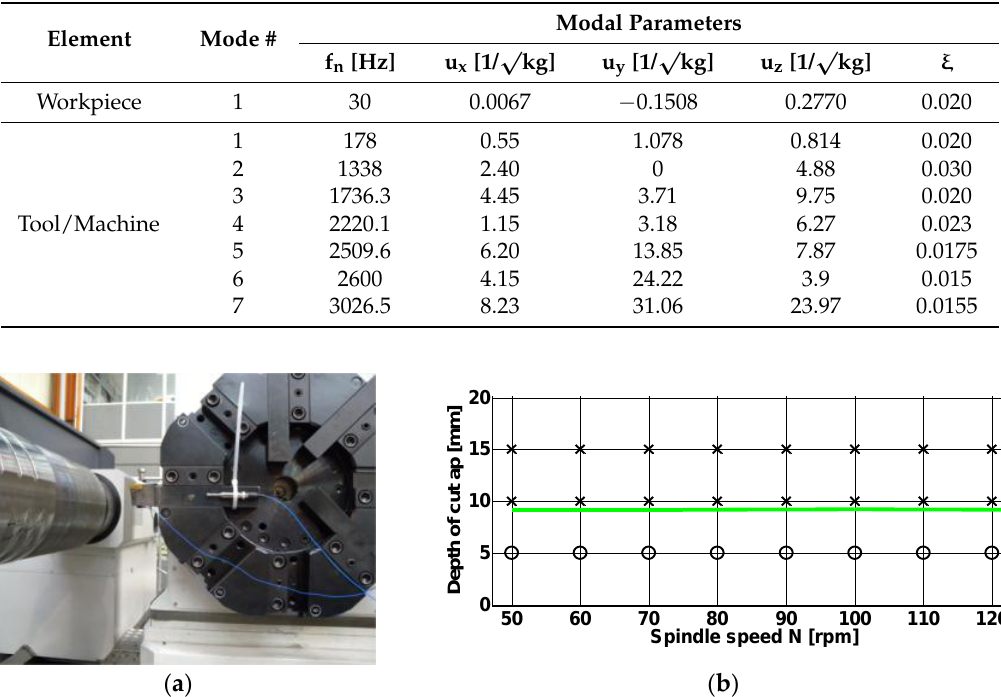
( b ) Figure 14. Frequency spectrum of the signal and surface finish: ( a ) Stable case a p = 5 mm/ n = 80 rpm; ( b ) Unstable case: a p = 10 mm/ n = 100 rpm. Machine designers are using the above approach in the design of machine variations, increasing the number of cases and simulations in the database, and it can reduce 87% of the cases of vibrations on roughing and semi-finishing turning operations. Finishing operations were not addressed because vibrations never appear at very low depths of cut values in turning. 6. Conclusions Industrial enterprises demand integrated information systems that can comprise the whole production process of any new product. In the case of companies dedicated to the machining of high-added value parts, or to the manufacturing of machine-tools, this demand is even higher, in view of the increasing customer expectations on the part quality and the competitiveness of this business. Considering that many of the usual machining problems have been solved by the state of art solutions but are not currently applied in daily production, it is crucial to have a reliable utility that can provide the greatest number of solutions in an easy and nimble way, which would be of invaluable help to enterprises in the decision-making process. This work presents a utility approach that emerged from the university, aimed at closing the lack of process decisions and assistance support in machining companies. Companies are engaged in day-to-day business, thinking more in the short rather than long term. The utility includes different models that were developed over the last ten years. This simulation utility incorporates not only predictive applications, but also the possibility to interact with the process so as to prepare and work with real cutting signals. In this way, it has an on-line/off-line dual application. It is capable of recording power signals, working with force and noise signals, and adjusting the response functions in frequency (FRF). With all this, this assistant tool involves different company departments for working in a cooperative way: (a) CAM engineers